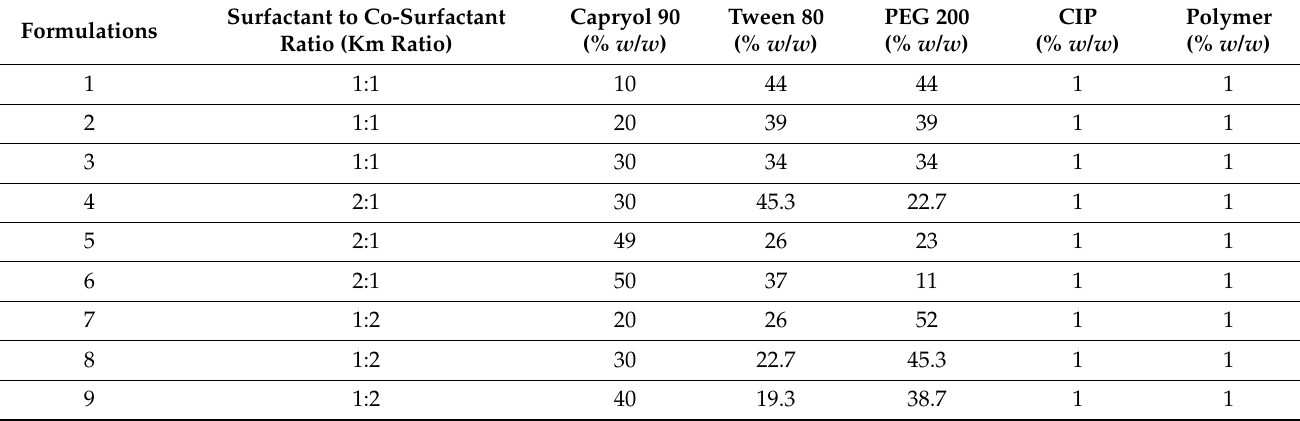
Table 1. Different formulation mixtures with varying concentrations of oil, surfactant, and co-surfactant.